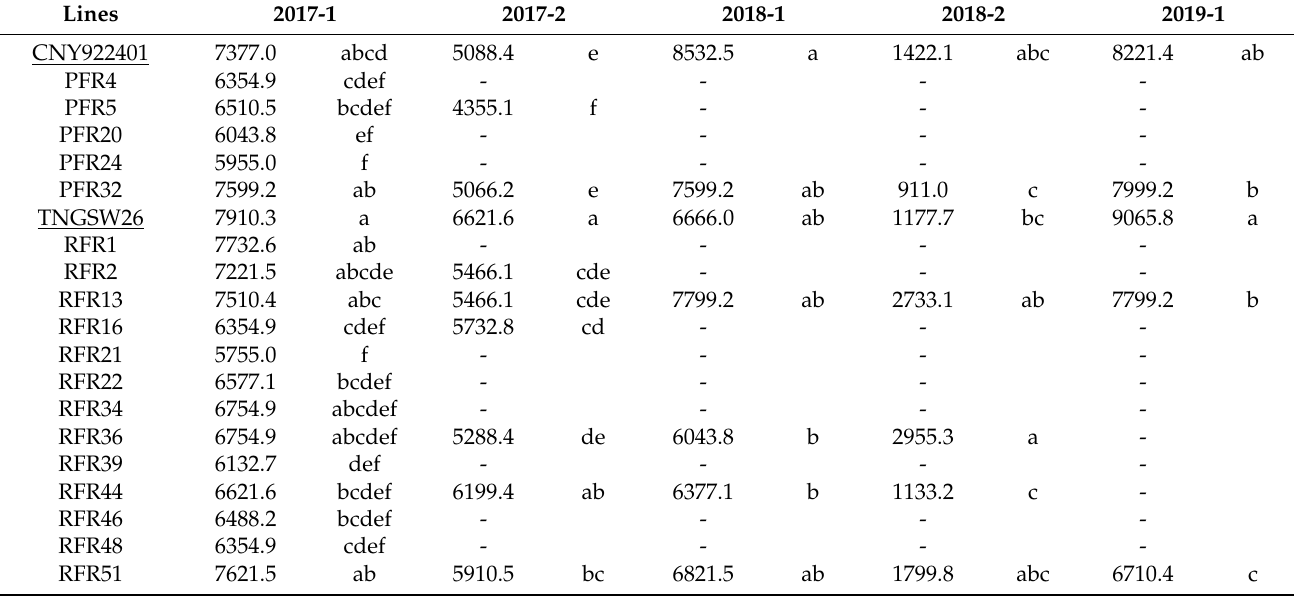
Figure 5. The grain appearance of brown rice for ( A ) TNG76, ( B ) TNG78, ( C ) CNY922401, and ( D ) F 3 lines of the purple functional rice population. Table 1. Five-season yield trials of the purple functional rice population (PFR) and red functional rice population (RFR).